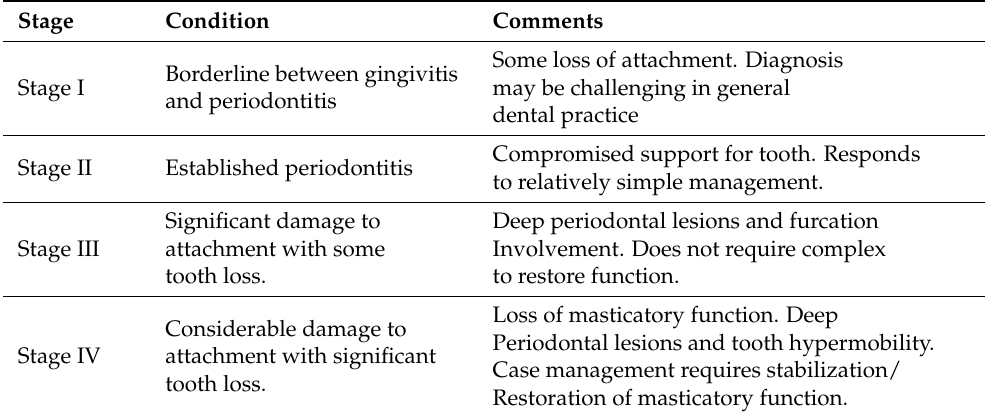
Table 1. Stages in the progression of periodontitis